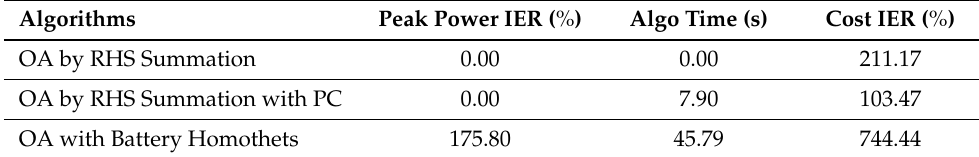
Table 2. Median values for outer approximations with N = 50 and M = 24.